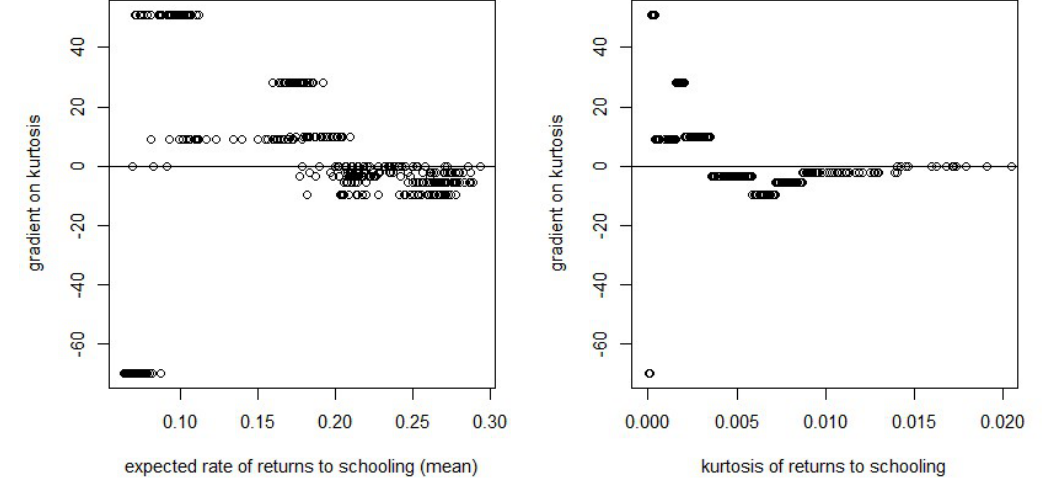
Figure 12. Spline Gradients on Kurtosis from Step